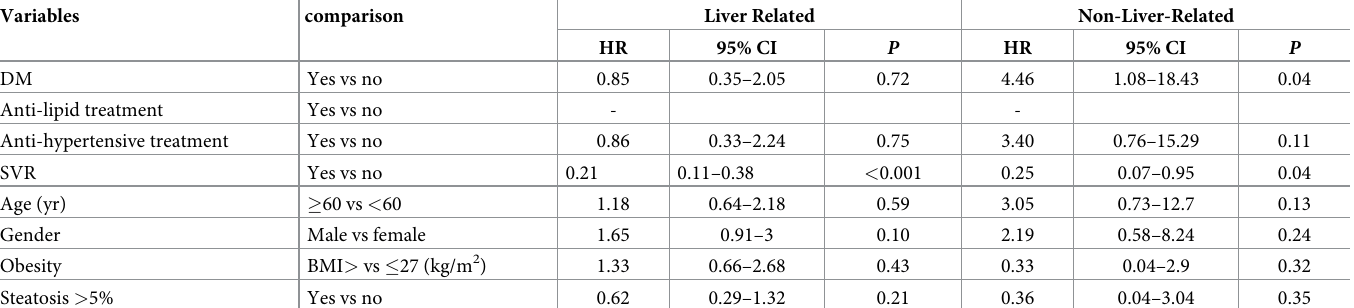
Table 7. Features Associated With Mortality in Advanced Fibrotic Patients (fibrosis score 3–4, N = 619) According to Cox Proportional Hazards Model:Results of Multivariate Analyses (If we consider bacterial infection as liver-related mortality).